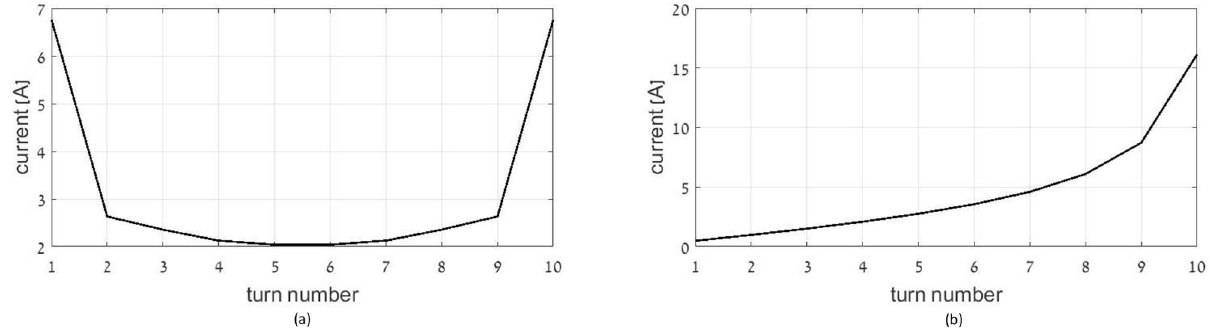
Fig 4. Current distribution in (a) the optimal single layer solenoid coil, and (b) the optimal spiral flat